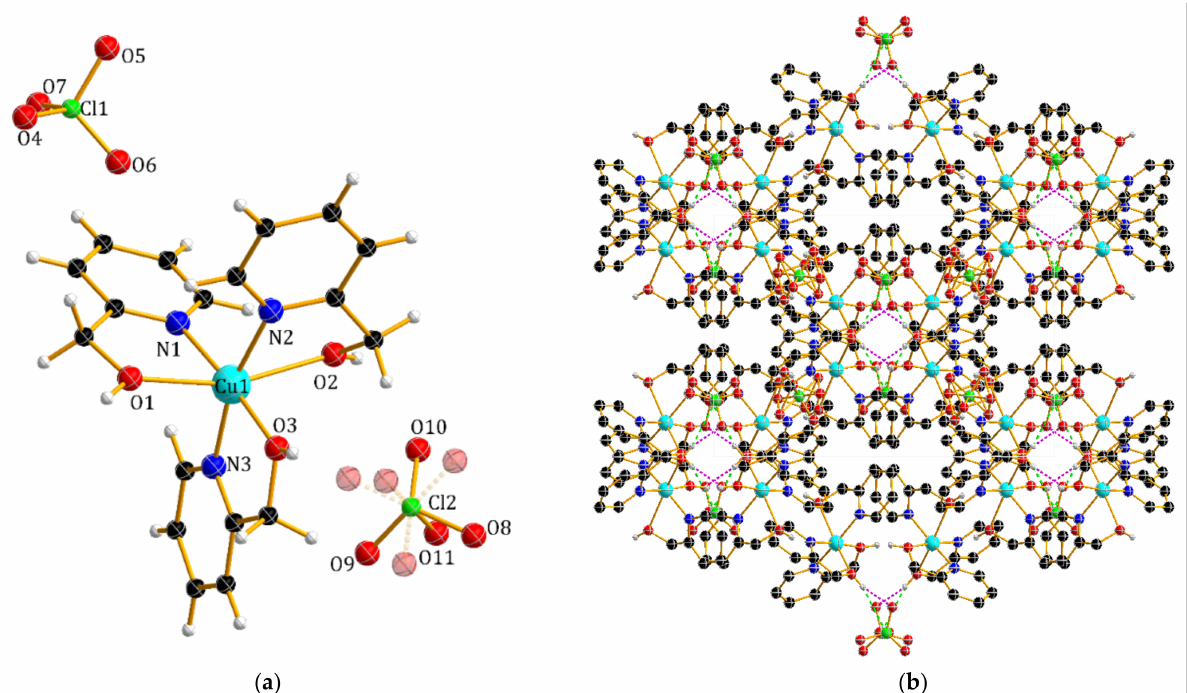
Figure 1. Perspective view of ( a ) the molecular structure and ( b ) the crystal packing with marked O-H ··· O/Cl bonds of [Cu(2-(HOCH 2 )py) 3 ](ClO 4 ) 2 ( 1